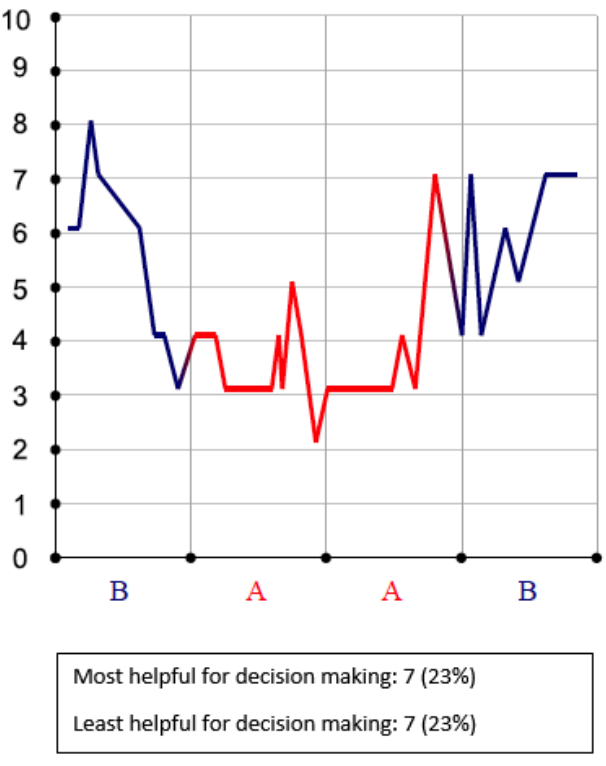
Figure 2. Pain intensity chronology (zero is no pain).